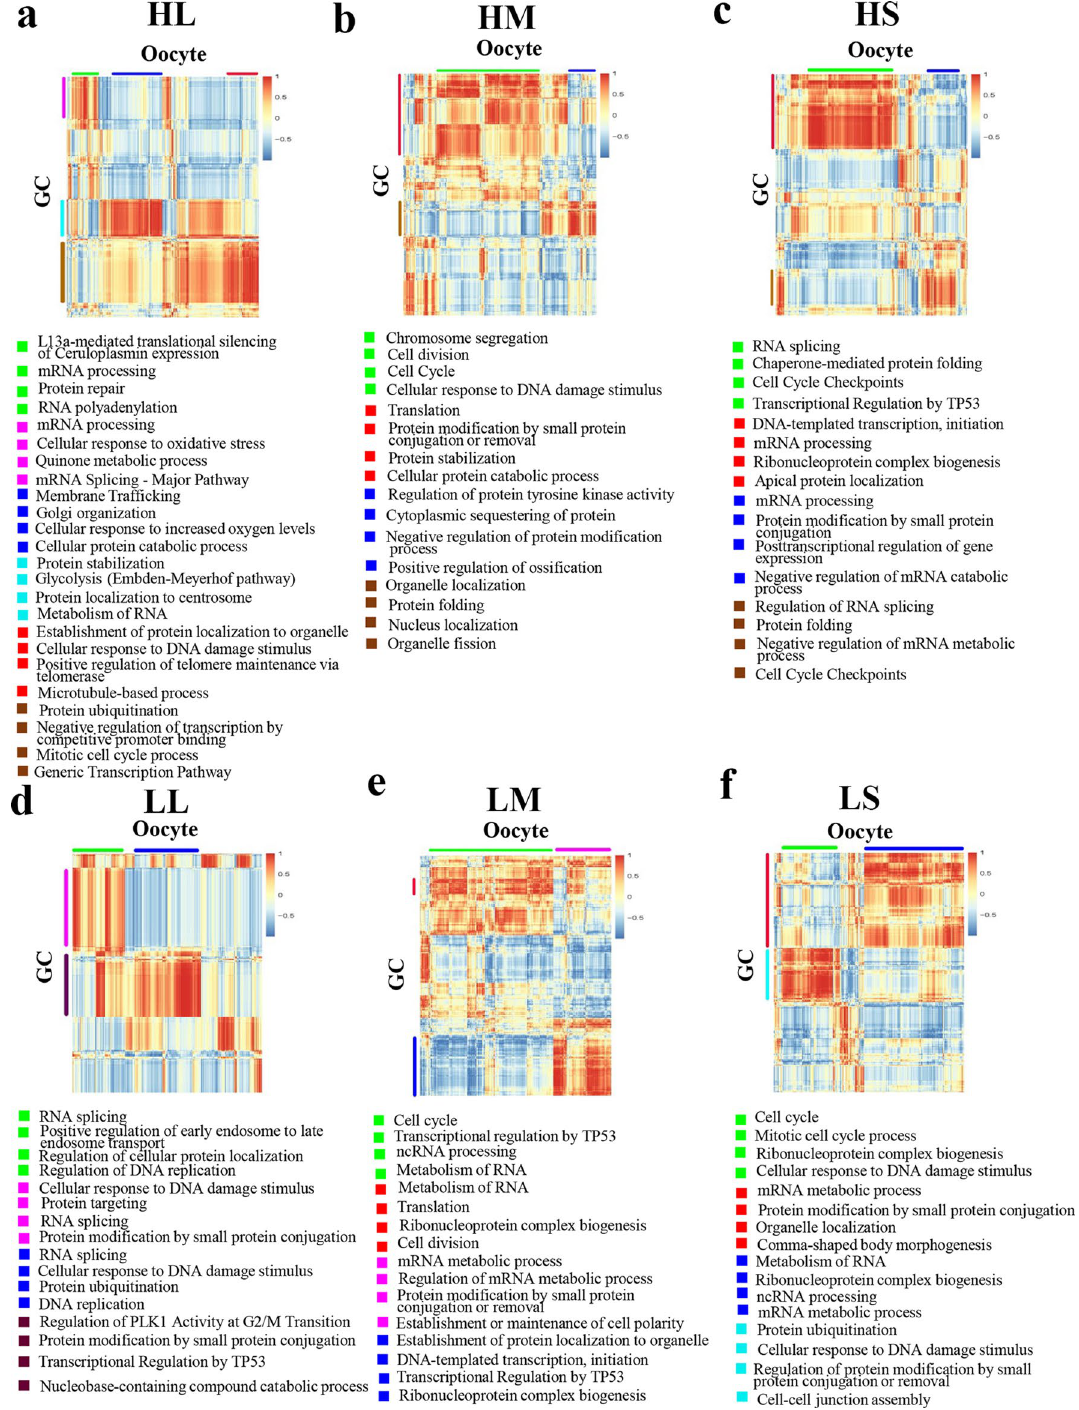
Figure 9. Functional co-expression between oocytes and GCs based on Spearman’s correlation coefficient. ( a ) Heatmap of genes expression between oocytes and GCs in large follicles of high fertility group; and the top four enriched functional pathways for the high correlation genes. ( b ) Heatmap of genes expression between oocytes and GCs in medium follicles of high fertility group; and the top four enriched functional pathways for the high correlation genes. ( c ) Heatmap of genes expression between oocytes and GCs in small follicles of high fertility group; and the top four enriched functional pathways for the high correlation genes. ( d ) Heatmap of genes expression between oocytes and GCs in large follicles of low fertility group; and the top four enriched functional pathways for the high correlation genes. ( e ) Heatmap of genes expression between oocytes and GCs in medium follicles of low fertility group; and the top four enriched functional pathways for the high correlation genes. ( f ) Heatmap of genes expression between oocytes and GCs in small follicles of low fertility group; and the top four enriched functional pathways for the high correlation genes. Horizontal and vertical bars next to the heatmaps annotate gene clusters with enriched biological